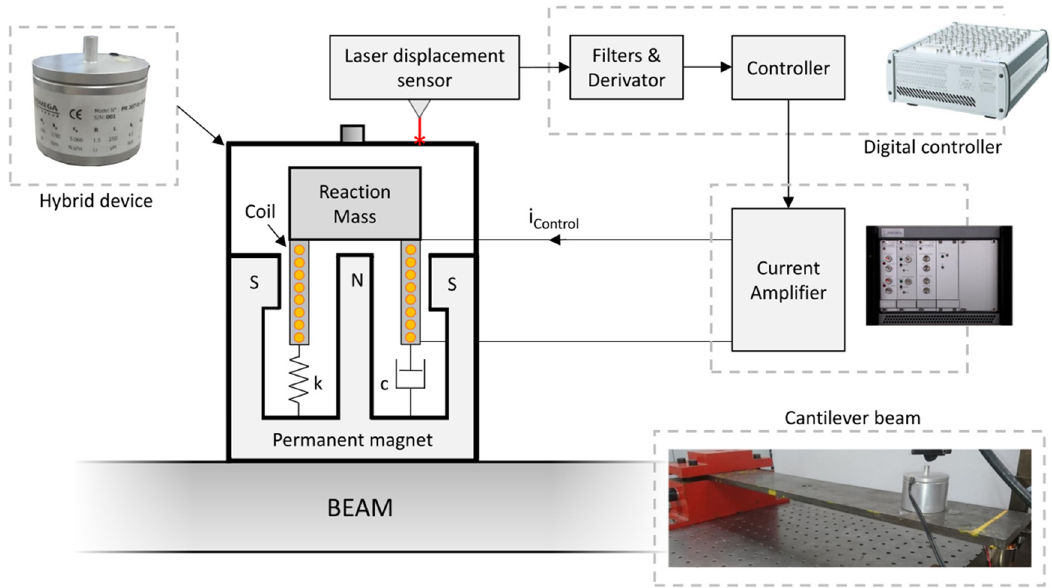
Fig. 9. The control system, its feedback loop, and the experimental